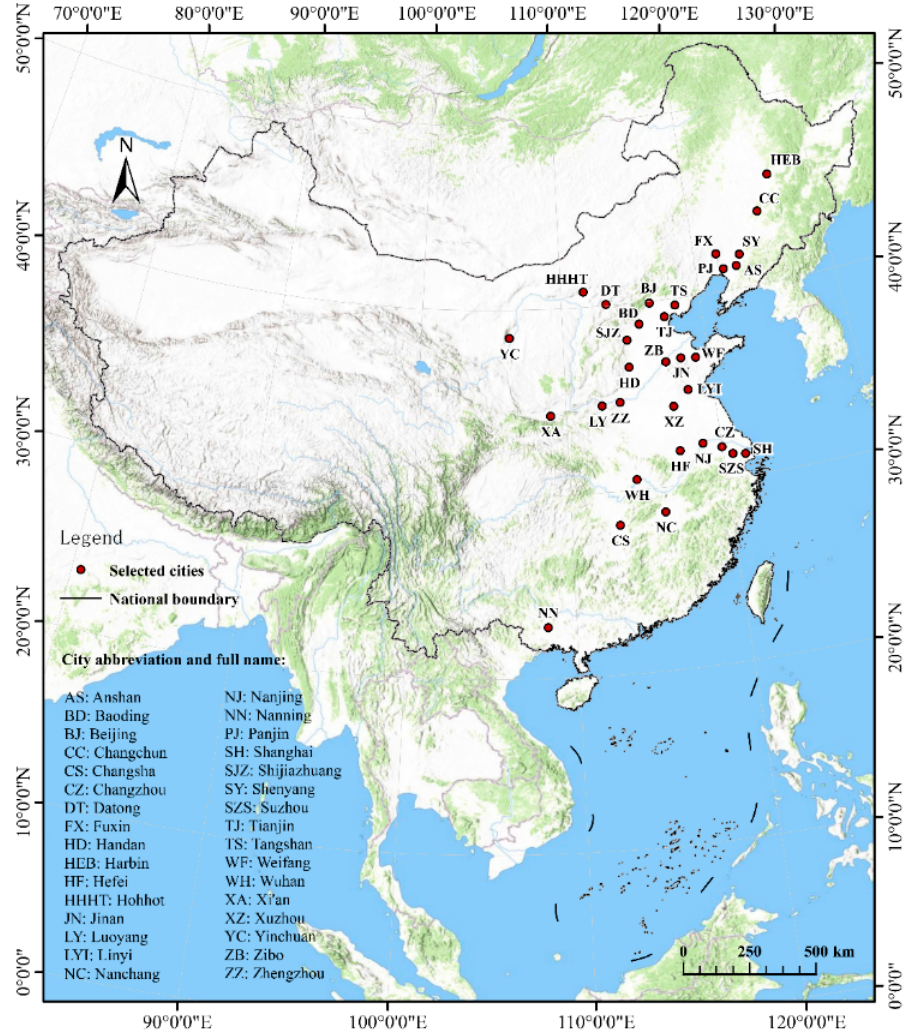
Figure 1. The locations of the 32 studied Chinese cities.